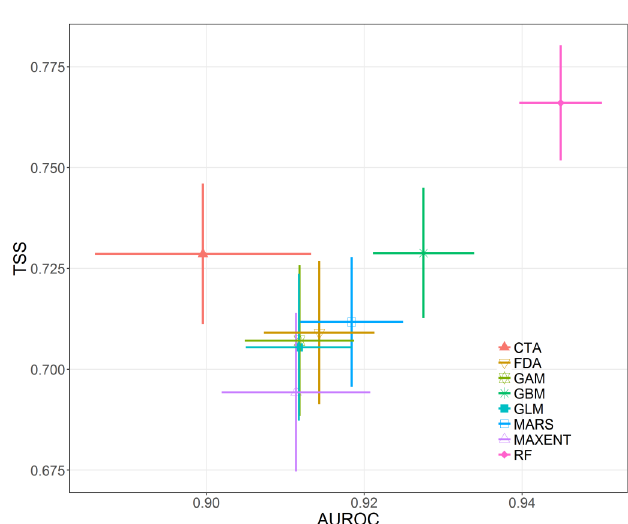
Figure 2. Mean (dots) and standard deviation (horizontal and vertical lines) of evaluation scores for the different modeling algorithms used with Biomod2. TSS: True Skill Statistic; AUROC: Area Under the Receiver Operating Char- acteristic curve.